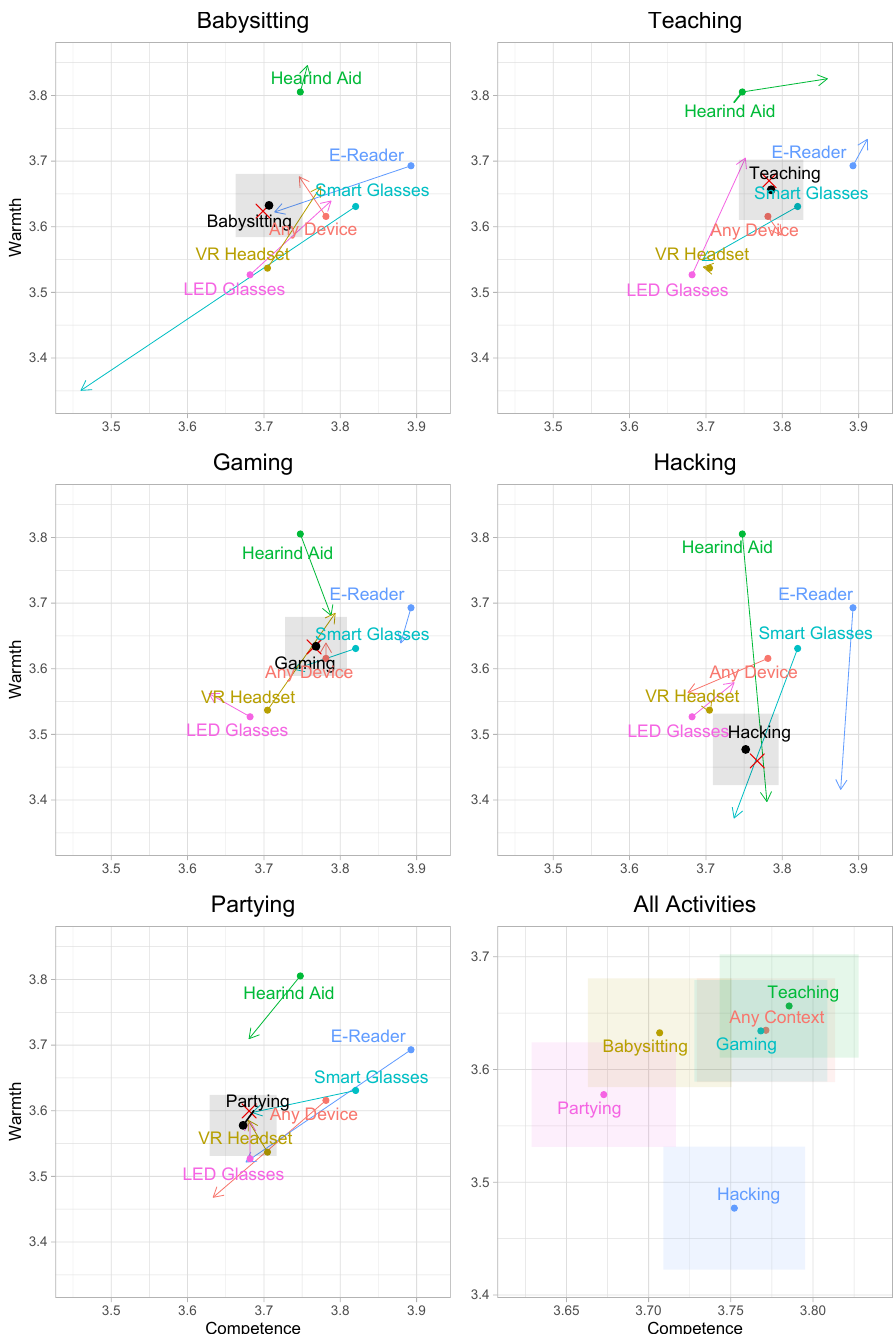
Figure 5. Mean ratings of warmth and competence for different wearable mobile devices and activities. Ratings of the activities babysitting, teaching, or gaming do not systematically “attract” ratings of users doing an activity with a body-worn mobile device. Rectangles show 95% confidence